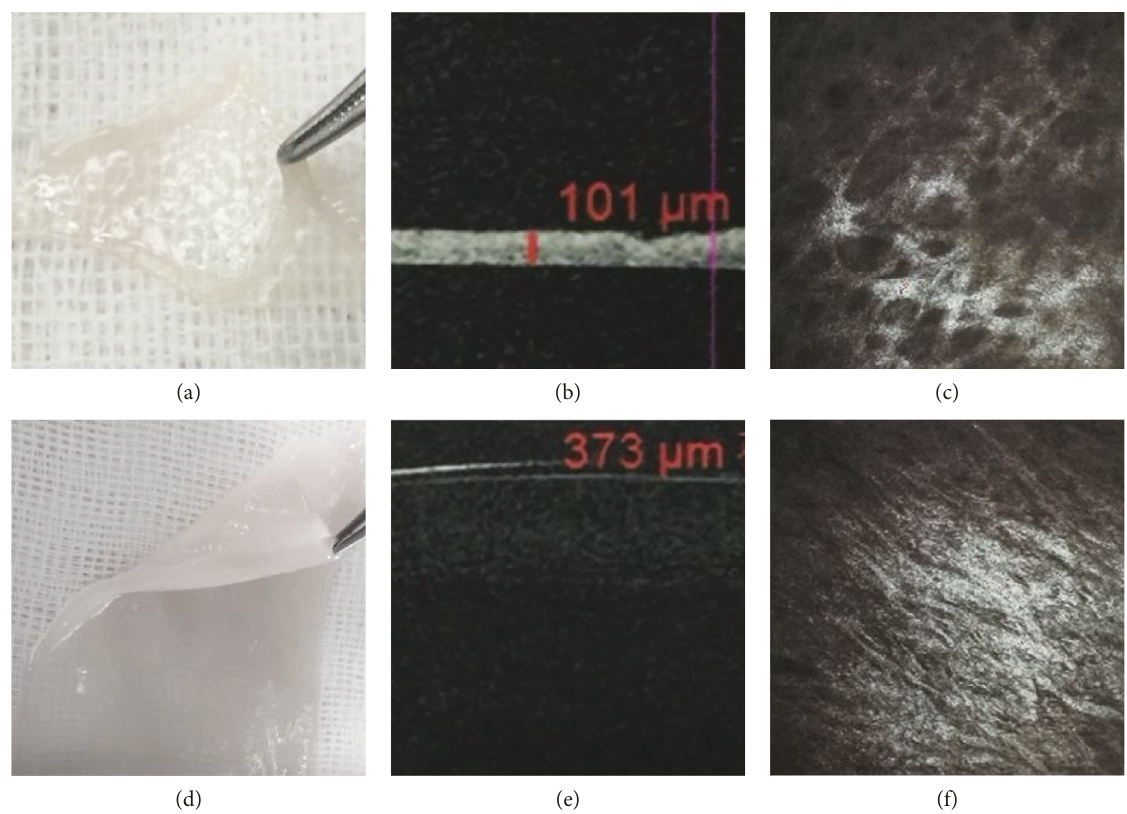
Figure 2: Characteristics of the AM and UCP. The thickness of human AM (a) is 97.6 ± 24.4 μ m ( n = 5 ) (b) with loose fi bers (c). The UCP (d) is much thicker (e) than the AM with a thickness of 398.6 ± 102.8 μ m ( n = 5 ) ( p < 0 001 ), and the stroma fi ber is compact (f). Table 1: Relevant clinical data of each